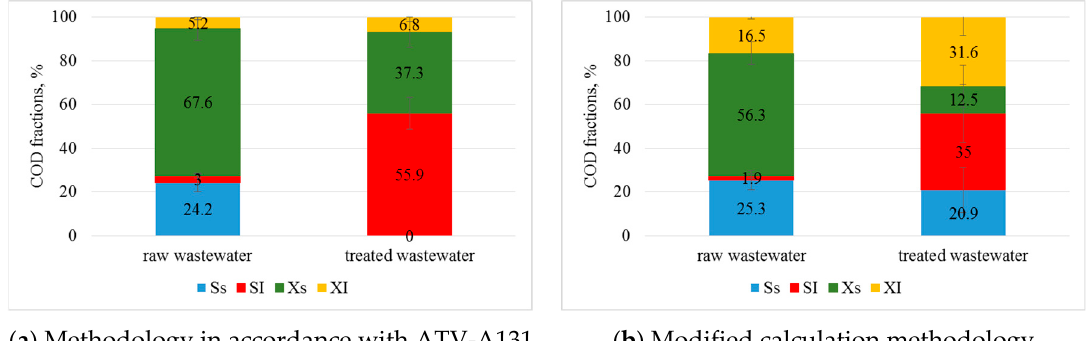
Figure 5. Average fraction shares in total COD of raw and treated wastewater. ( a ) Methodology in accordance with ATV-A131; ( b ) modified calculation methodology.